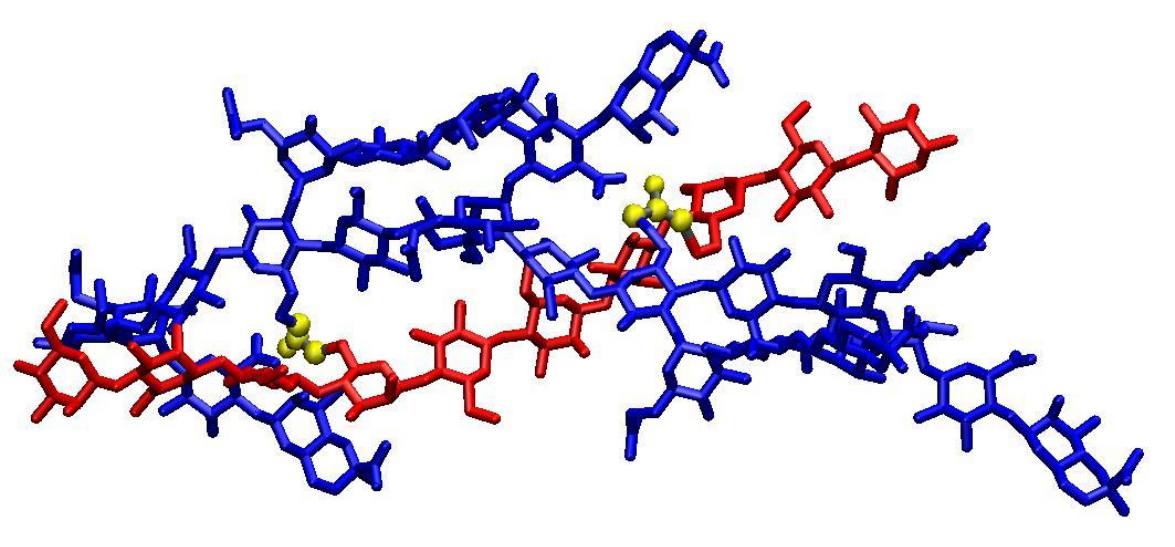
Figure 6. Molecular representation of the junction domain in XGE hydrogel. Epichlorohydrin cross-links are evidenced in yellow. Xanthan and glucomannan chains are shown in blue and red coloros, respectively. Hydrogen atoms are not